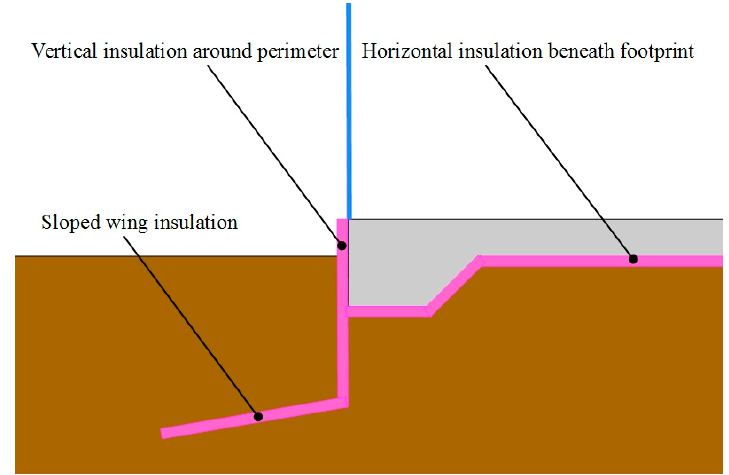
Figure 2. Common locations for ground insulation on buildings.